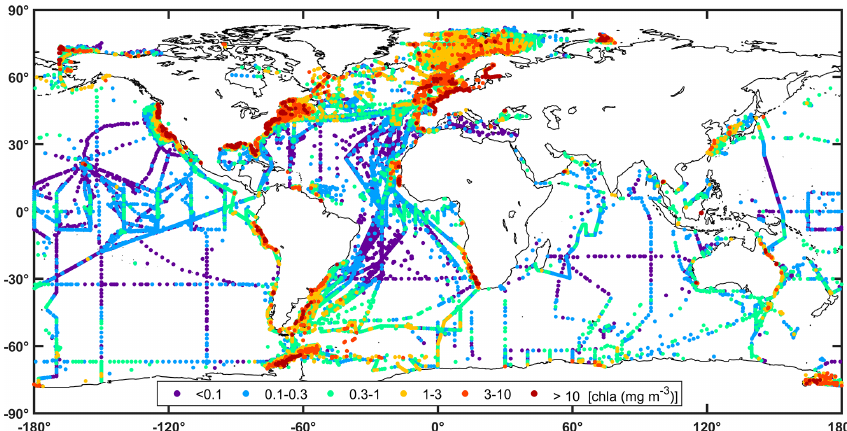
Figure 8. Global distribution of chlorophyll- a concentration per interval of the observed value. All chlorophyll data were considered, but for a given station, HPLC data were selected if available.